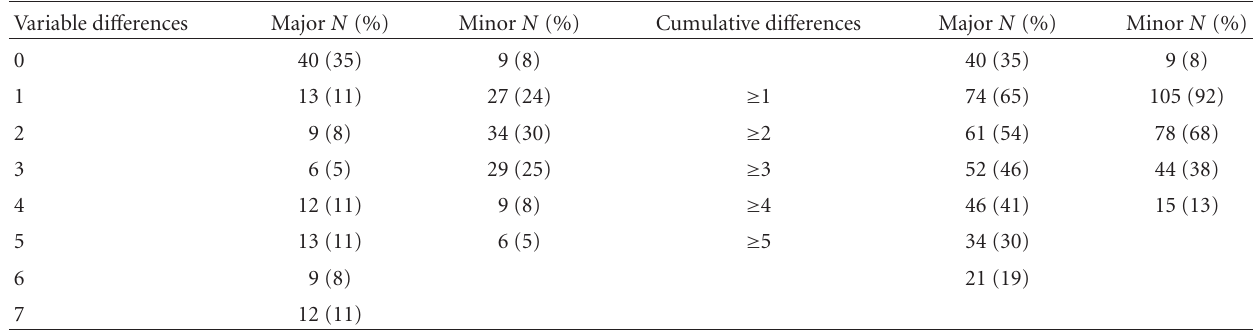
Table 2: Percentages of major and minor discrepancies found in full-text publications compared with their respective abstracts presented